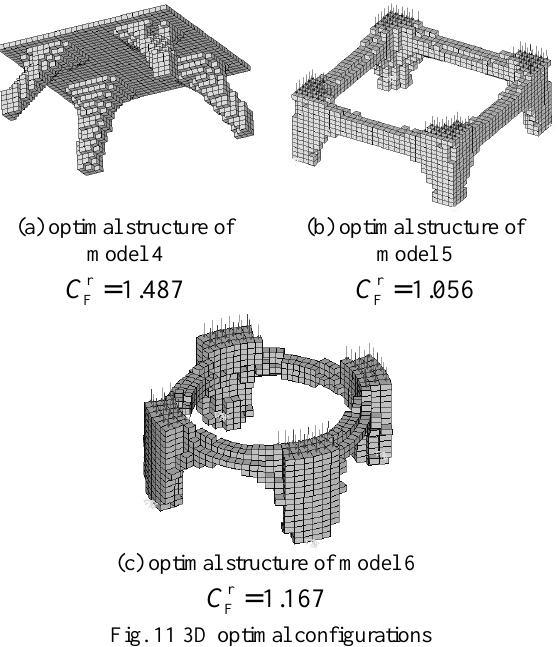
Fig. 11 3D optimal